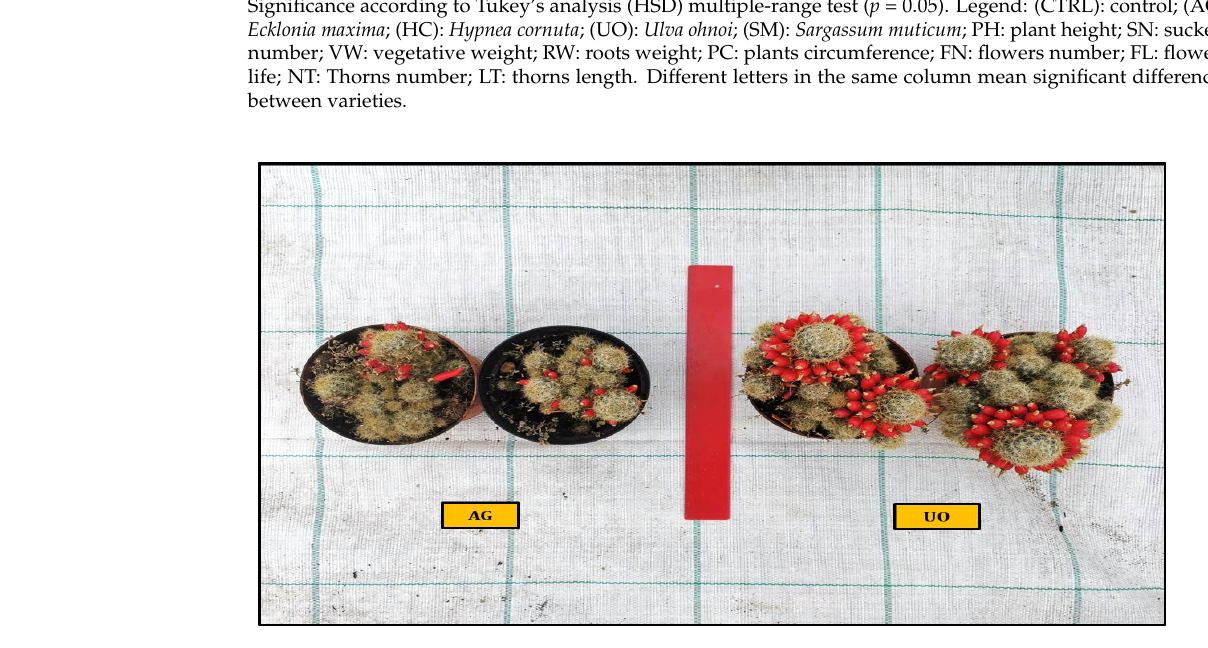
Figure 4. Comparison of the vegetative growth of Ulva ohnoi (UO) and Hypnea cornuta (HC) in Mammillaria glassii.